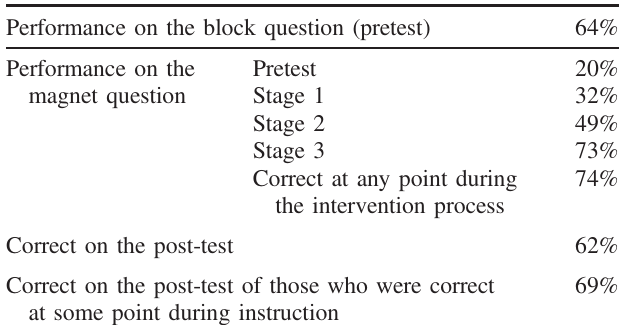
TABLE III. Student performance on pretest, intervention questions, and